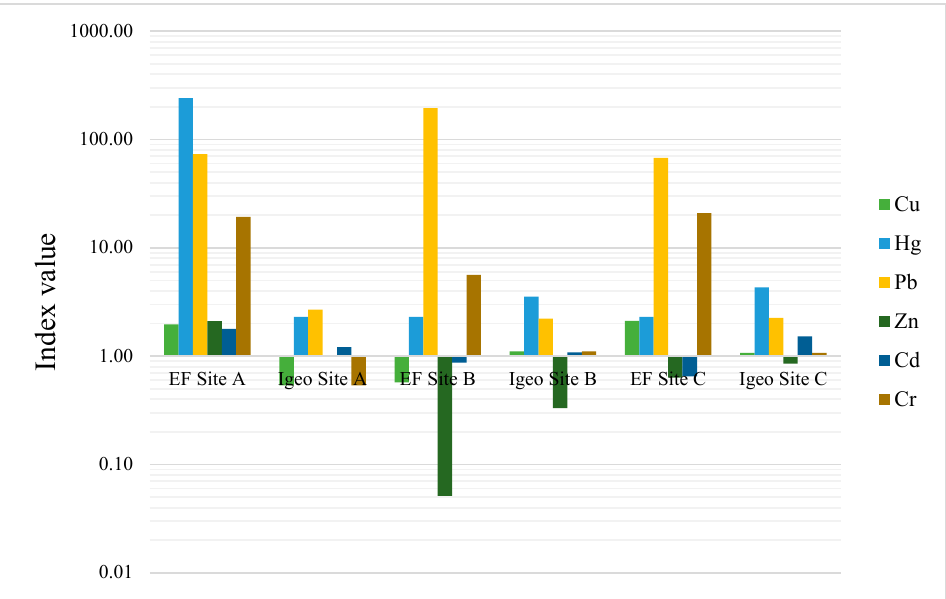
Figure 4. Variation in the concentration (Igeo) and the source (EF) of heavy metals contaminants in the Pawara soils.